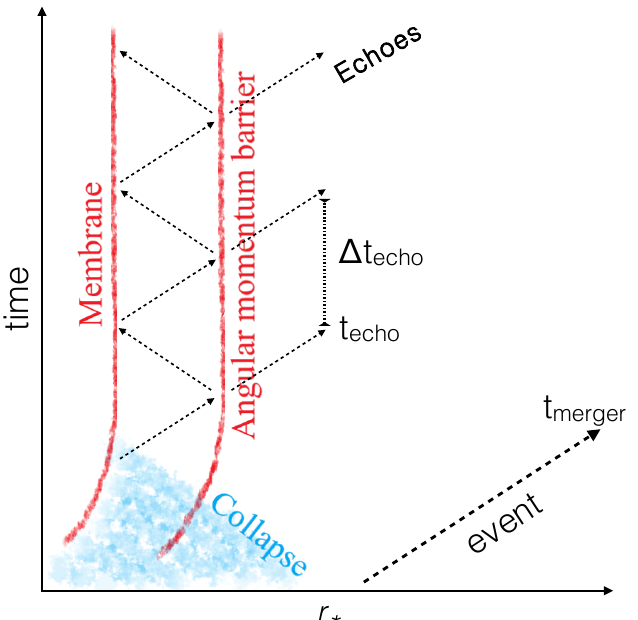
Figure 16. GW echoes following a collapse of binary neutron star merger event from a cavity of membrane-angular momentum barrier [20].